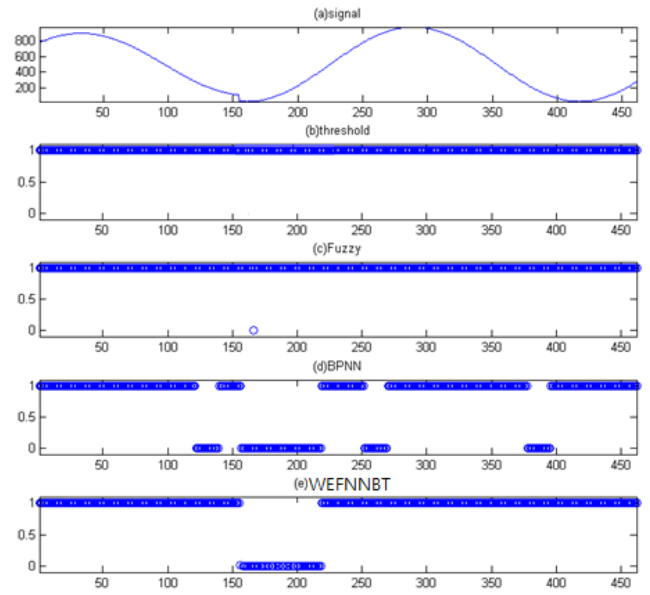
Figure 11. ( a ) Waveform of 0.75-pu and 180 degree sag, ( b ) state of protective relay based on identification with TM for sag, ( c ) state of protective relay based on identification with FA for sag, ( d ) state of protective relay based on identification with BPNN for sag, and ( e ) state of protective relay based on identification with proposed WEFNNBT for sag.